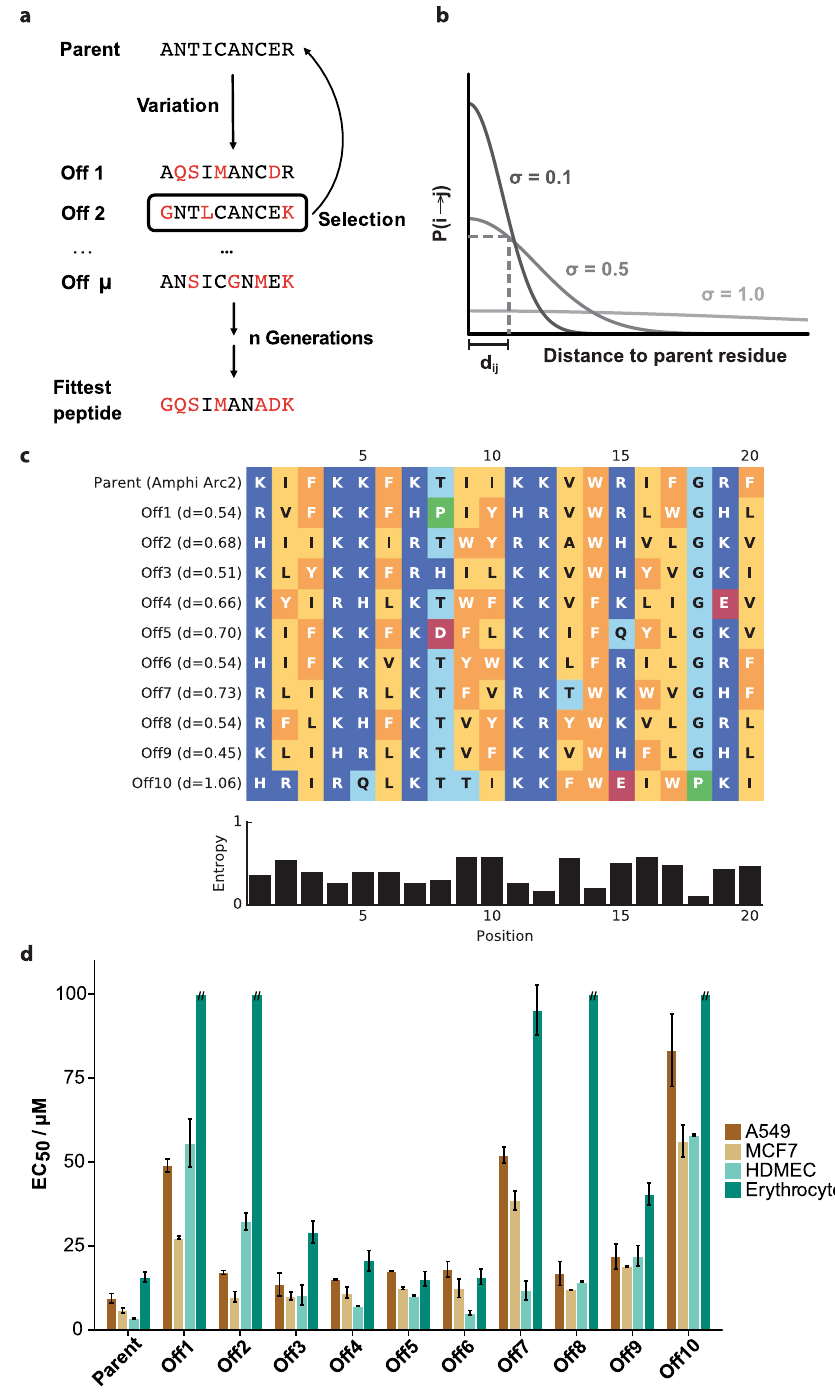
Figure 2. Peptide selectivity optimization by simulated molecular evolution (SME). ( a ) Principle of the iterative variation or mutation and selection steps in SME, starting with the model parent peptide “ANTICANCER”. ( b ) Probability of the mutation of amino acid residue i in the parent sequence to residue j in the offspring as a function of the amino acid pairwise similarity ( d ij ). The sigma ( σ ) parameter controls the sequence diversity among the offspring. ( c ) Comparison of the 10 generated offspring sequences and their Euclidean distance to the parent sequence according to the Grantham similarity matrix. The [0, 1] normalized Shannon entropy (in bit in the graph) of each residue position is shown below. Residue coloring is as follows: light blue: polar, dark blue: positively ionizable, red: negatively charged, yellow: hydrophobic, orange: aromatic, green: proline. ( d ) Peptide activity towards the A549 and MCF7 cancer cell lines (EC 50 ), the noncancer HDMEC primary cells (EC 50 ), and the human erythrocytes (HC 50 ). The error bars give the standard deviation of N = 2 independent measurements with six technical replicates